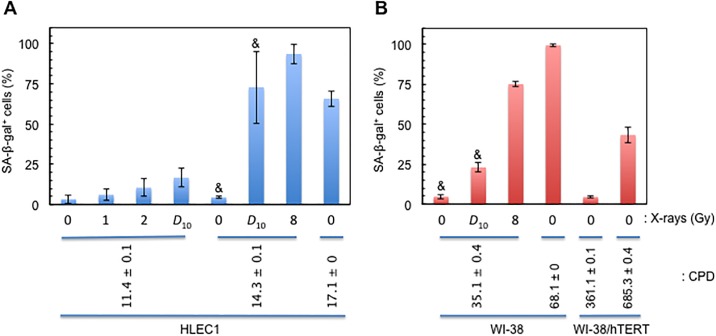
Alterations in SA-β-gal positivity.(A) HLEC1. (B) WI-38 and WI-38/hTERT. CPD shown for HLEC1 at CPD 17.1 ± 0.0 and WI-38/hTERT at CPD 685 ± 0.4 is at the time of plating, and SA-β-gal positivity shown is at 7 days after plating. CPD shown for WI-38 at CPD 68.1 ± 0.0, and WI-38/hTERT at CPD 361 ± 0.1 is at the time of plating, and SA-β-gal positivity shown is at 8 days after plating. CPD shown for HLEC1 at CPD 11.4 ± 0.1 and 14.3 ± 0.1 and WI-38 at CPD 35.1 ± 0.4 is at the time of irradiation with 1, 2, D10 or 8 Gy (at dose rate of 0.44 ± 0.01, 0.43 ± 0.00 and 0.43 ± 0.01 Gy/min, respectively), and SA-β-gal positivity shown is at 7 days postirradiation. Data represent means and SDs of three independent experiments, where 192–2048 cells were counted for each sample. *These data were taken from [58].